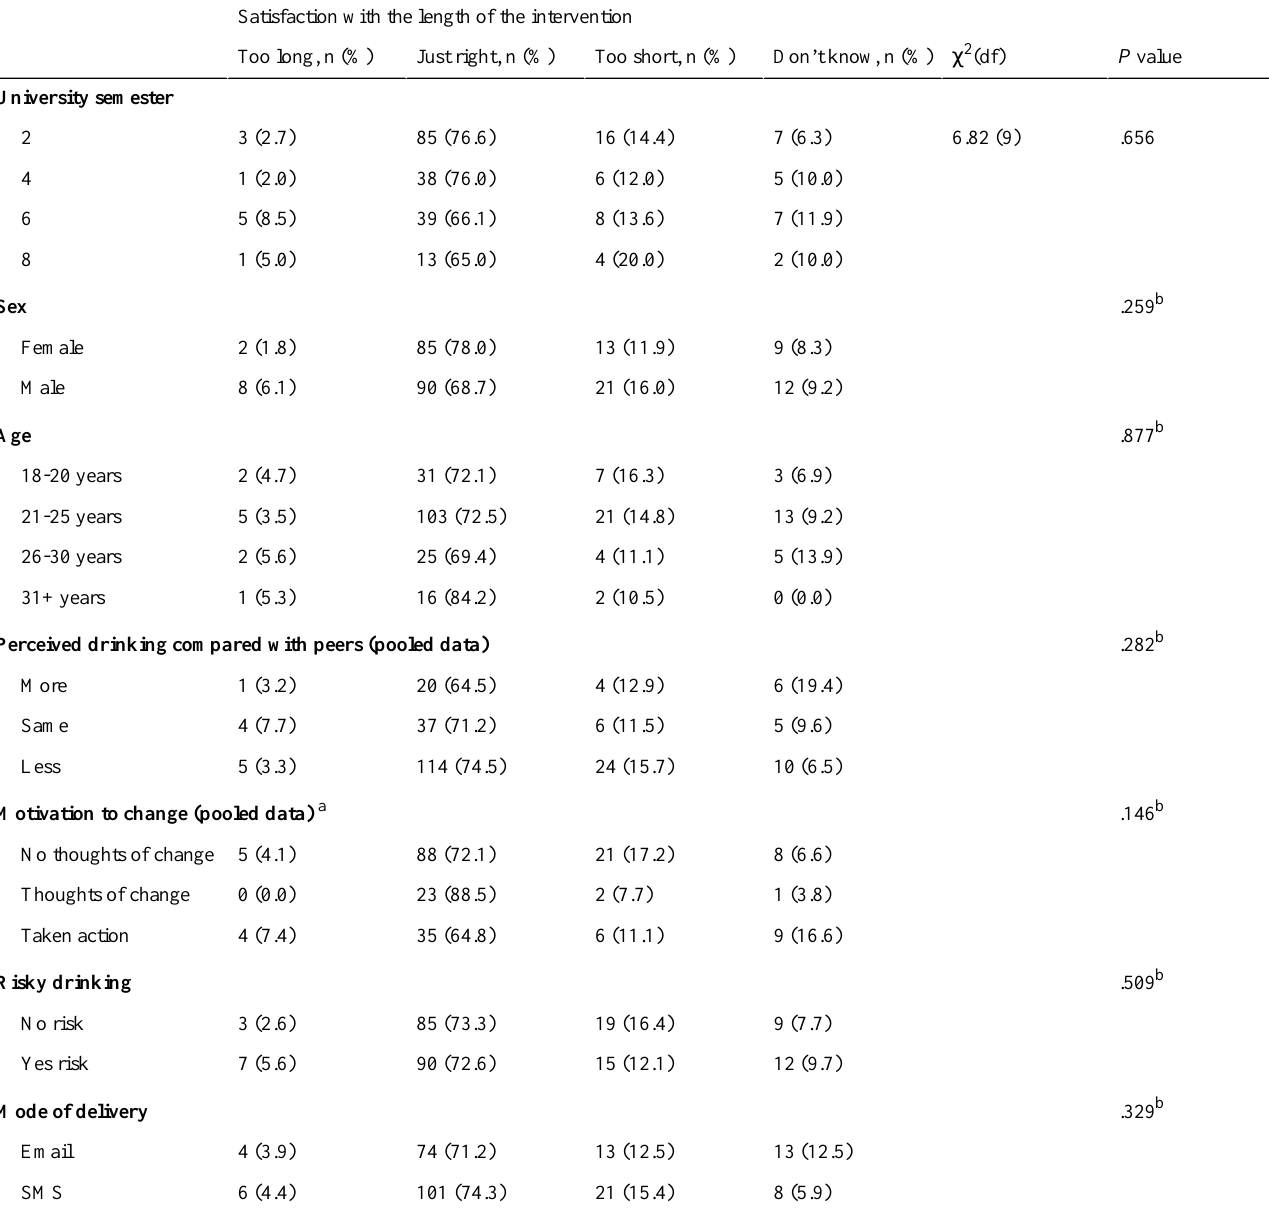
Table 3. Satisfaction with the length of the intervention in relation to background characteristics